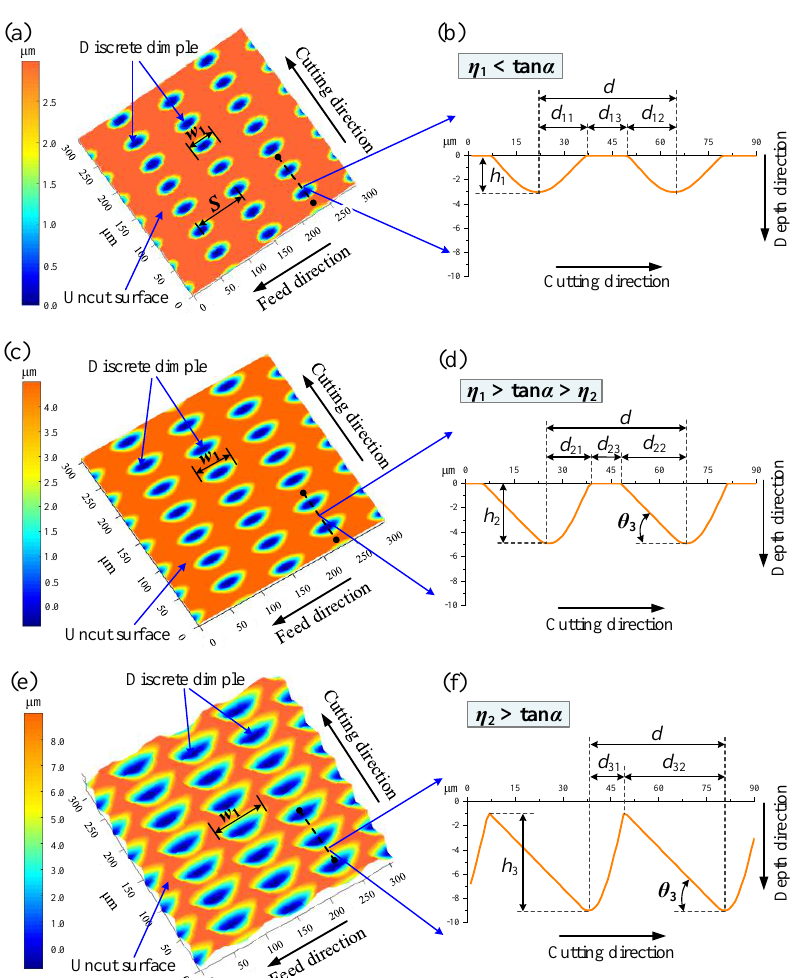
Figure 19. Simulated surface topographies and dimple profiles under processing parameters of f us = 19,670 Hz, R = 20 mm, DOC = 1 μm, n = 400 r/min, f = 80 μm/rev, α = 15°, R c = 100 μm . ( a , b ) A = 2.0 μm; ( c , d ) A = 3.9 μm; ( e , f ) A = 8.0 μm.